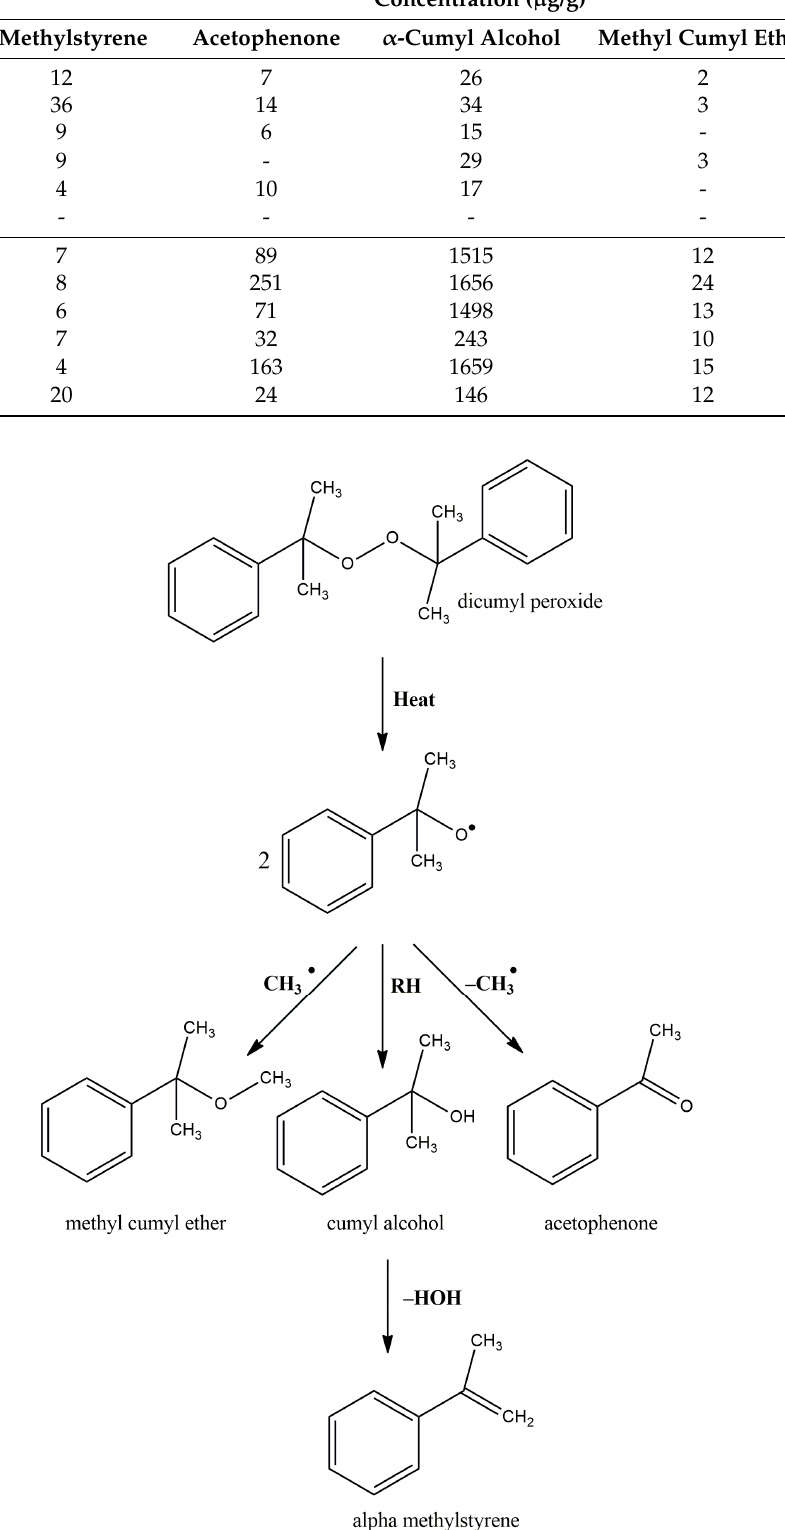
Table 10. Concentration of the most significant VOCs identified for uncured and cured materials by SHS-GC-MS analysis.